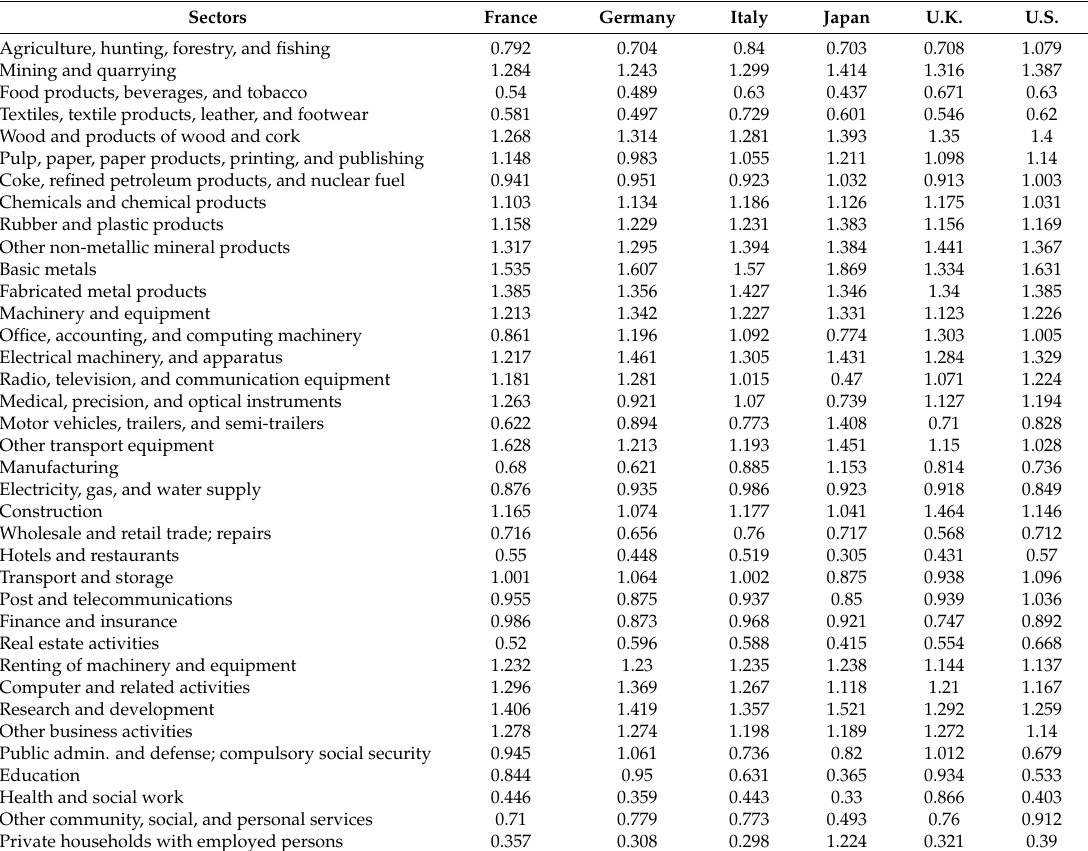
Table 2. Normalized Forward Linkage in Major OECD